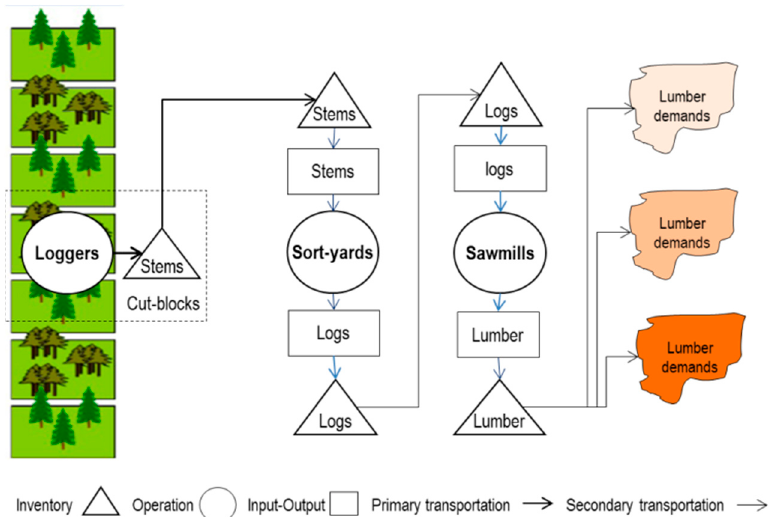
Figure 1. Forest to lumber British Columbia (BC) coastal supply chain case study.